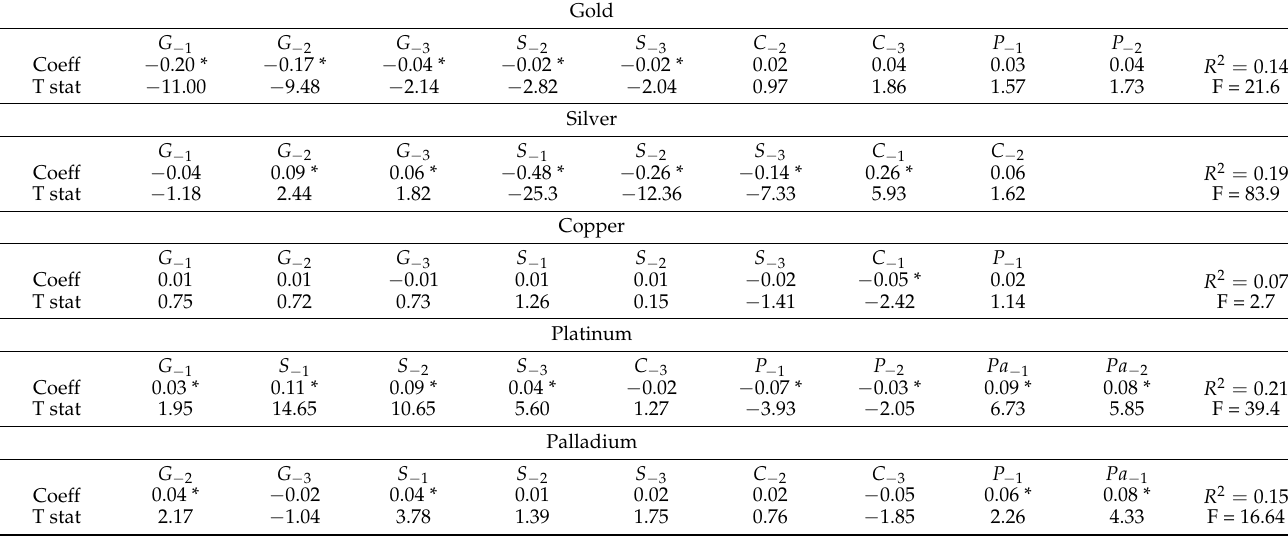
Table 2. Results of the regression